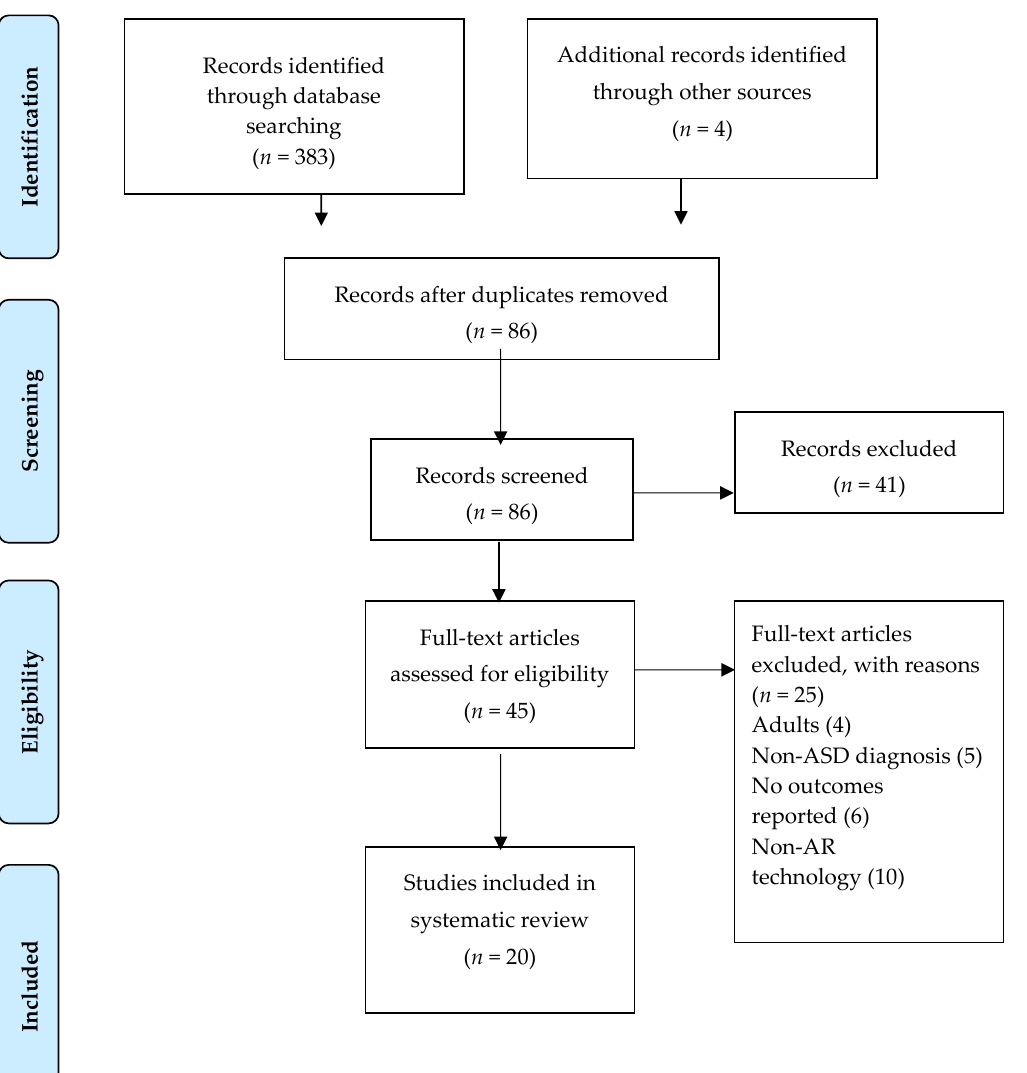
Figure 1. Preferred Reporting Items for Systematic Reviews and Meta-Analyses (PRISMA) flowchart of the study selection process for this systematic review.